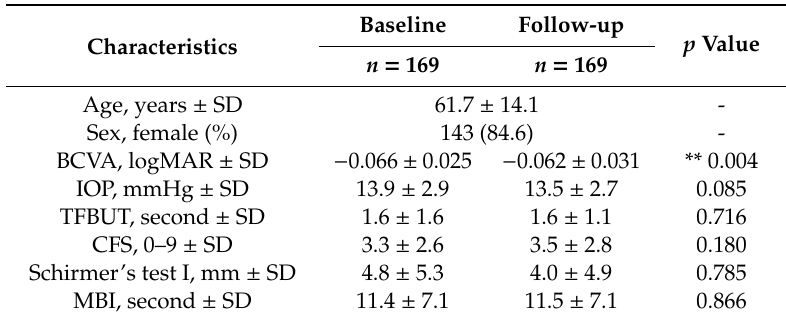
Table 1. The characteristics of study